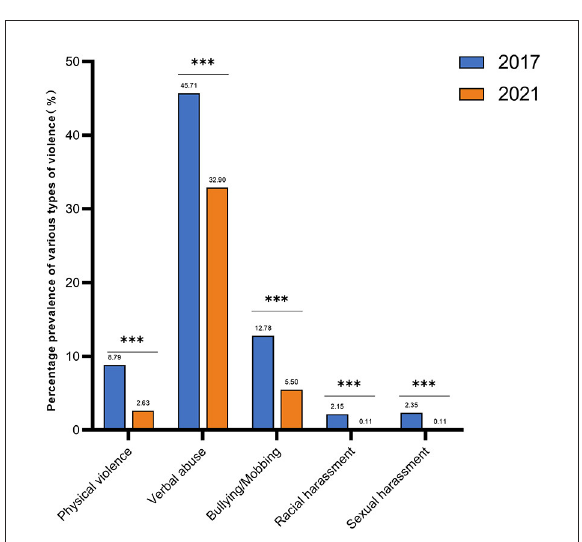
FIGURE2 Graph of changes in the prevalence of various types of violence among HWs. Both 2017 and 2021 in the figure refer to the year. From 2017 to 2021, all types of violence decreased. The prevalence of verbal abuse has been the highest. Also, the statistical analysis of the two surveys showed the largest decrease in verbal abuse. ***indicates that P < 0.001. Physical violence, Pearson’s Chi square = 32.775, P < 0.001; Verbal abuse; Pearson’s Chi square = 32.610, P < 0.001; Bullying/Mobbing, Pearson’s Chi square = 30.002, P < 0.001; Racial harassment, Pearson’s Chi square = 17.051, P < 0.001; Sexual harassment, Pearson’s Chi square = 18.945, P <